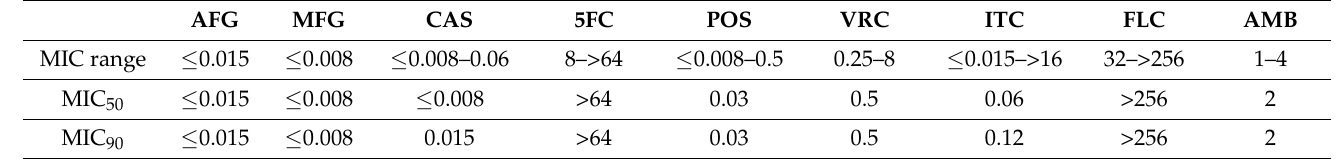
Table 1. The MEC and MIC data of nine antifungal agents using the YeastOne TM method (μg /mL).